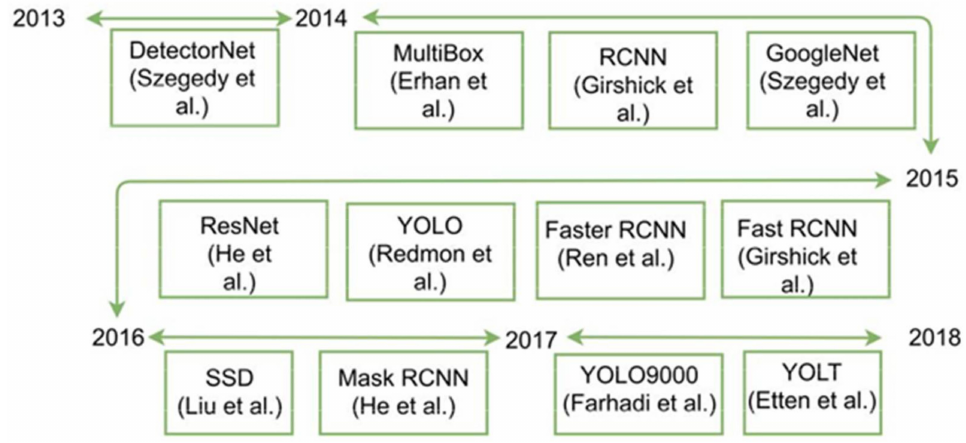
Figure 1. Major contributions of object detection frameworks and convolutional neural